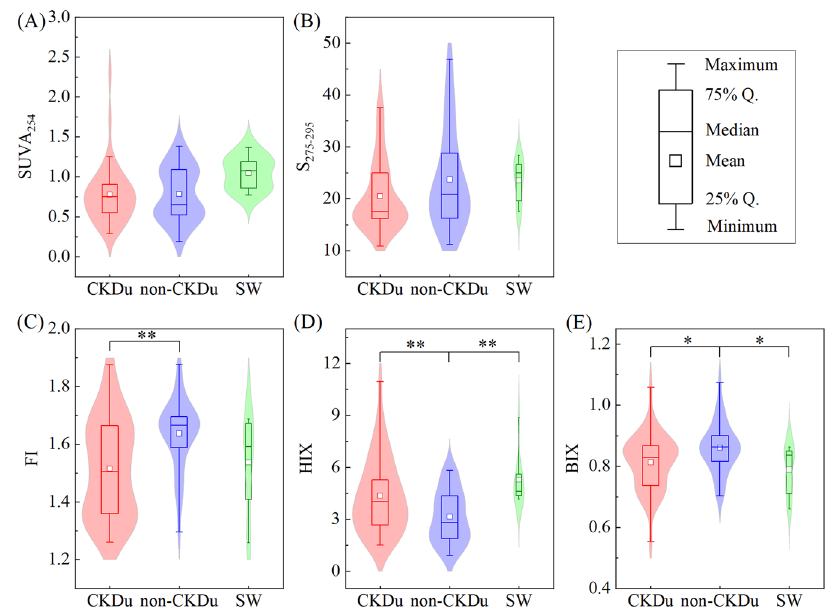
Fig. 1 The spectral indices of DOM. The upper point of the black box is the maximum and the lower is the minimum; the upper boundary of the black box is the 75th percentile and the lower is the 25th percentile, and the middle white square is the average value. The density diagram outside the box diagram represents the density probability. The signi fi cant difference of p < 0.01 and the signi fi cant difference of p < 0.05 have been marked with two asterisks and an asterisk in spectral indices between two different groups,